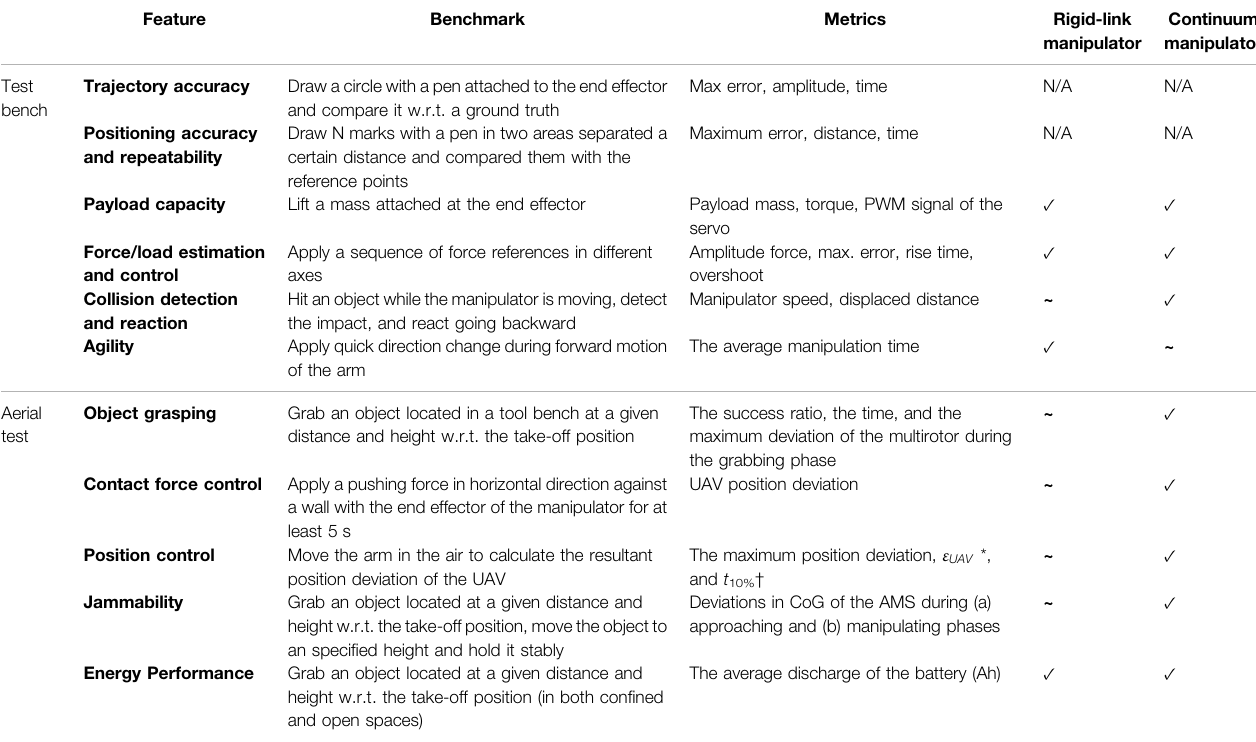
TABLE 1| Features and related benchmarkstoevaluate theperformanceofAMS.Thelast twocolumns comparedthe ACMSswiththeir rigid-link counterparts (~:capable, ✓ : superior). Feature Benchmark